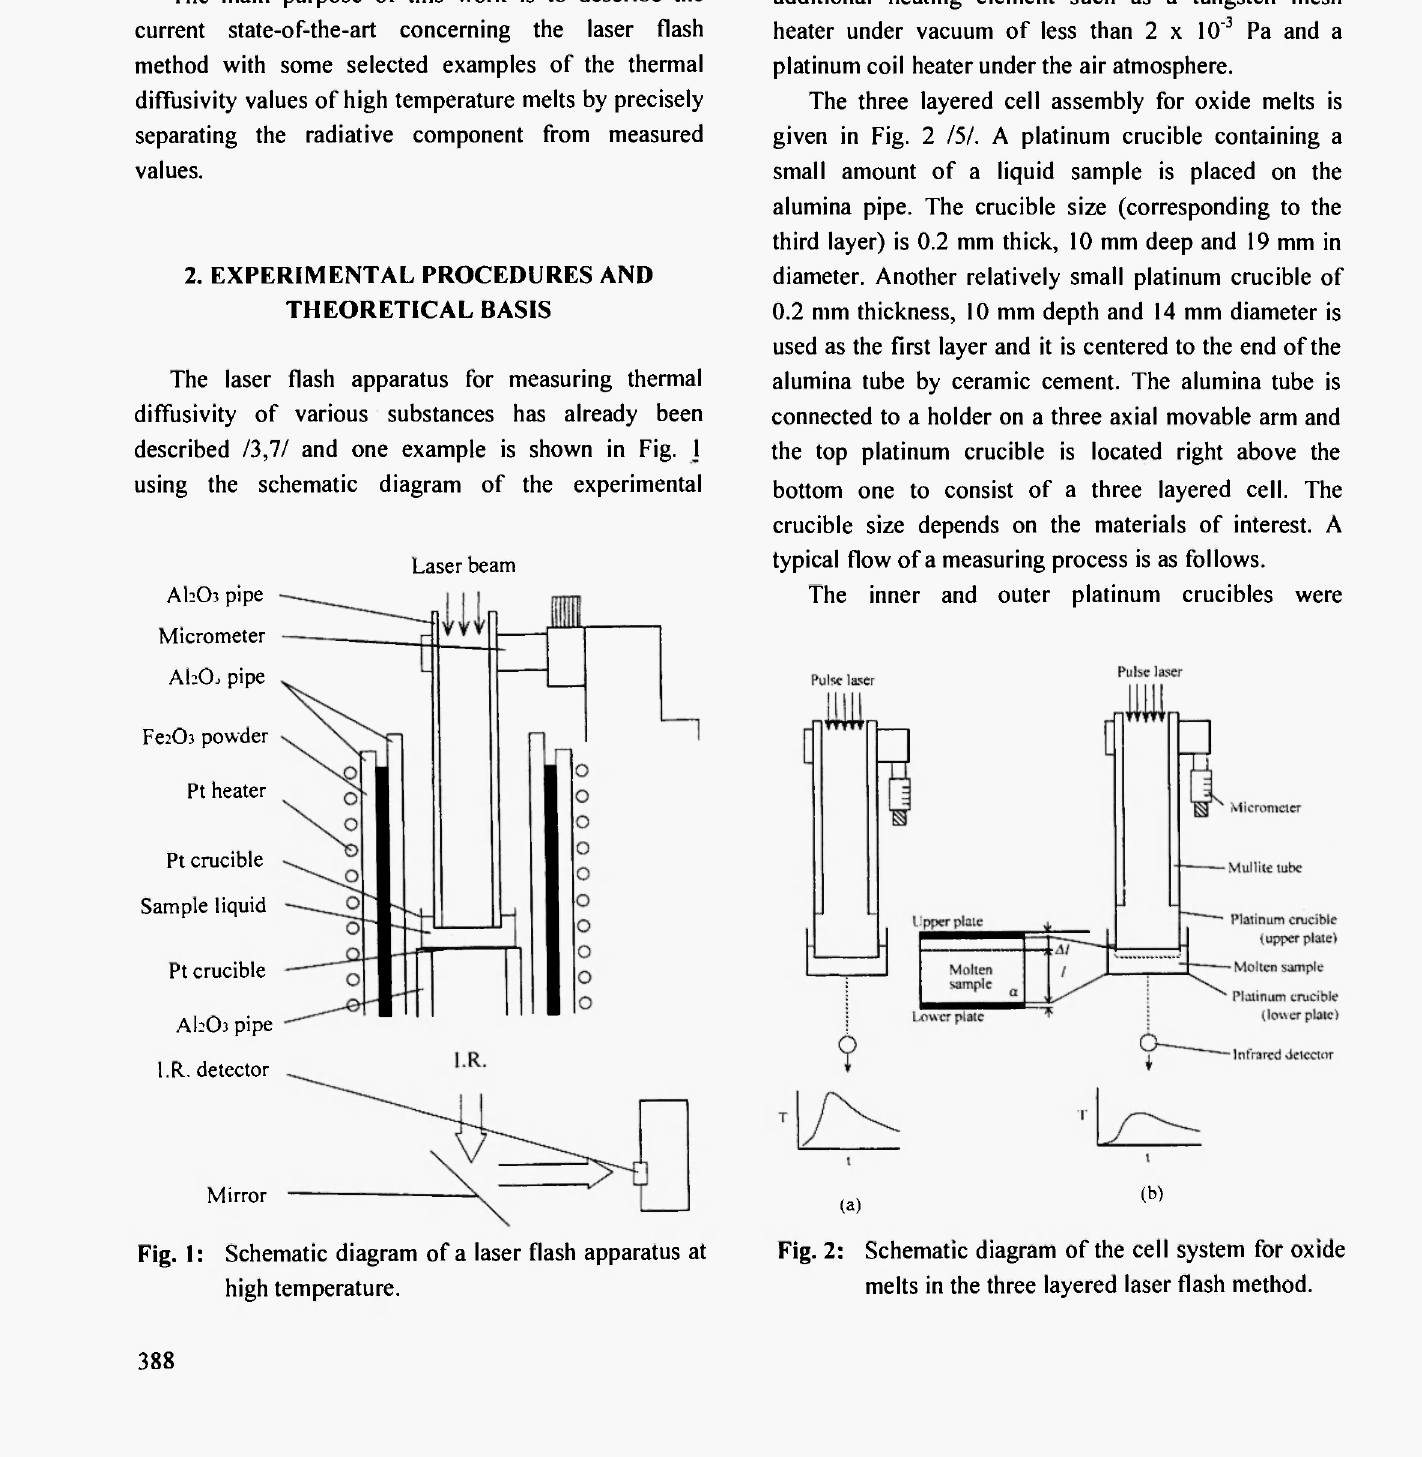
Fig. 1: Schematic diagram of a laser flash apparatus at high temperature.